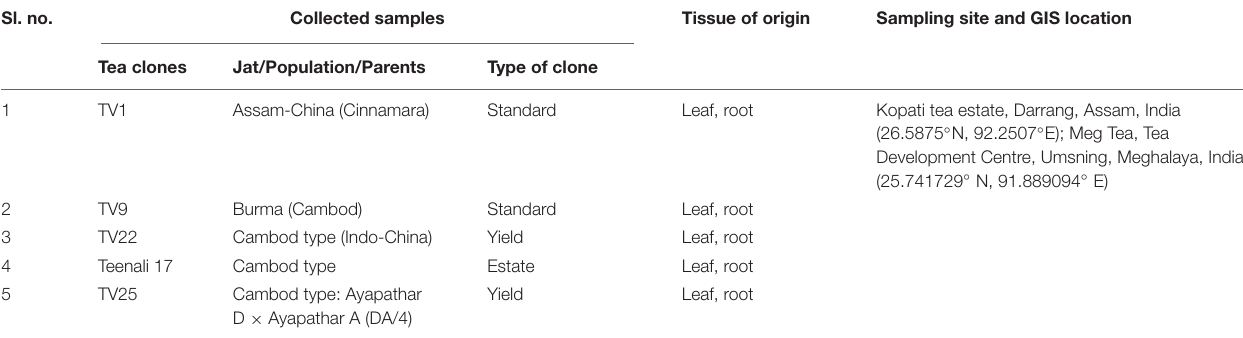
TABLE 1 | Collection of Tea